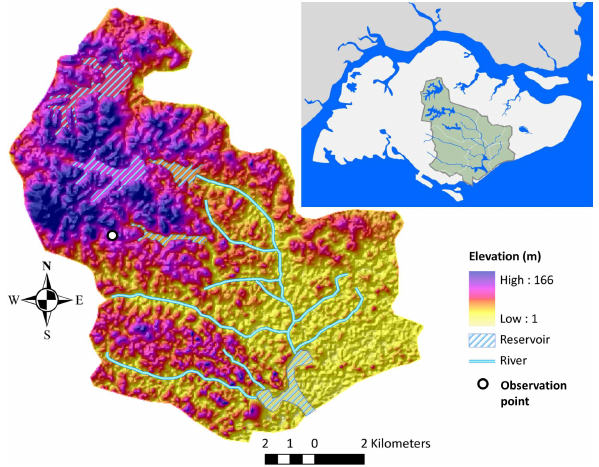
Fig. 1. Components of the integrated distributed hydrological model. Fig. 2. Location of the Marina catchment within